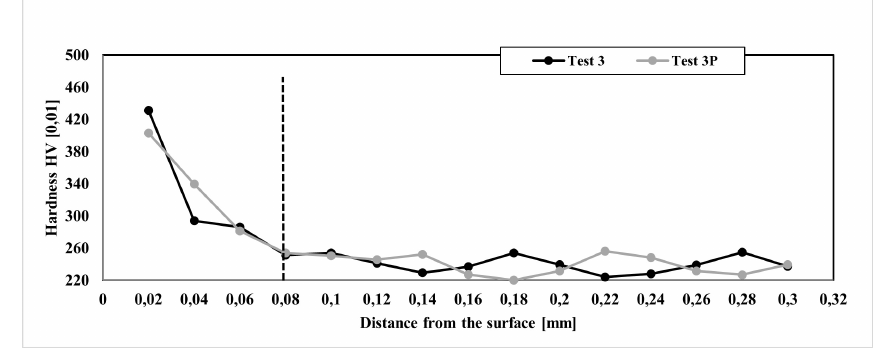
Figure 6. Hardness values of samples - Test 3 and Test 3P.